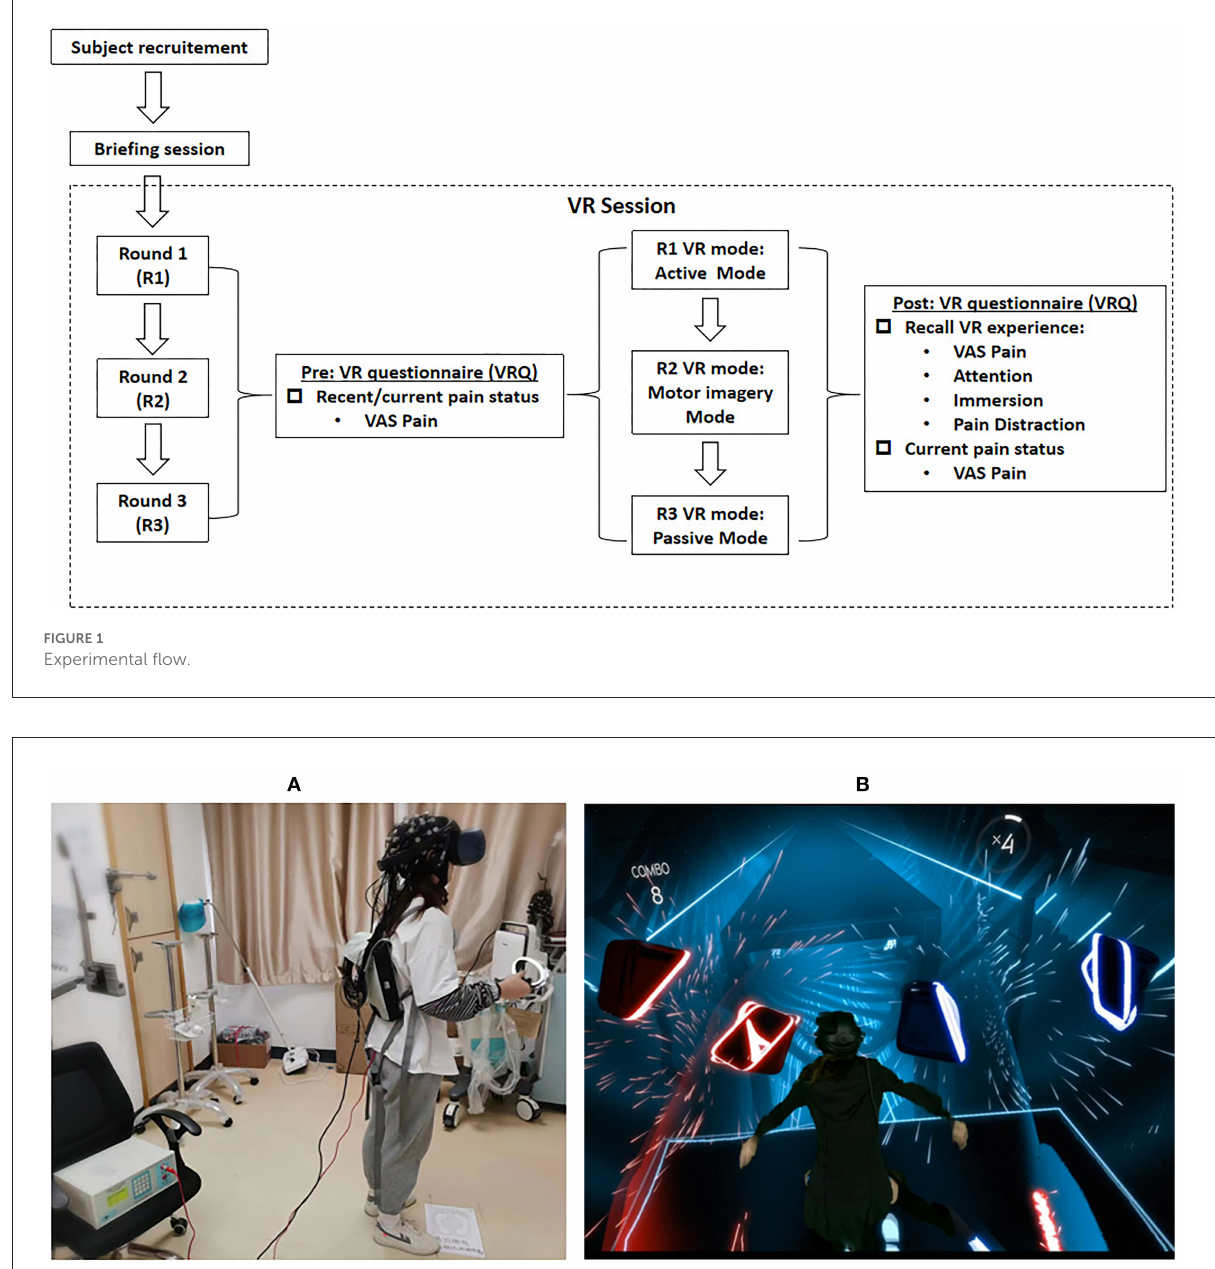
FIGURE2 Experimental scenario. (A) The scenario of real world; (B) the scenario of virtual world (Virtual Scenario of Beat Saber, n.d.).